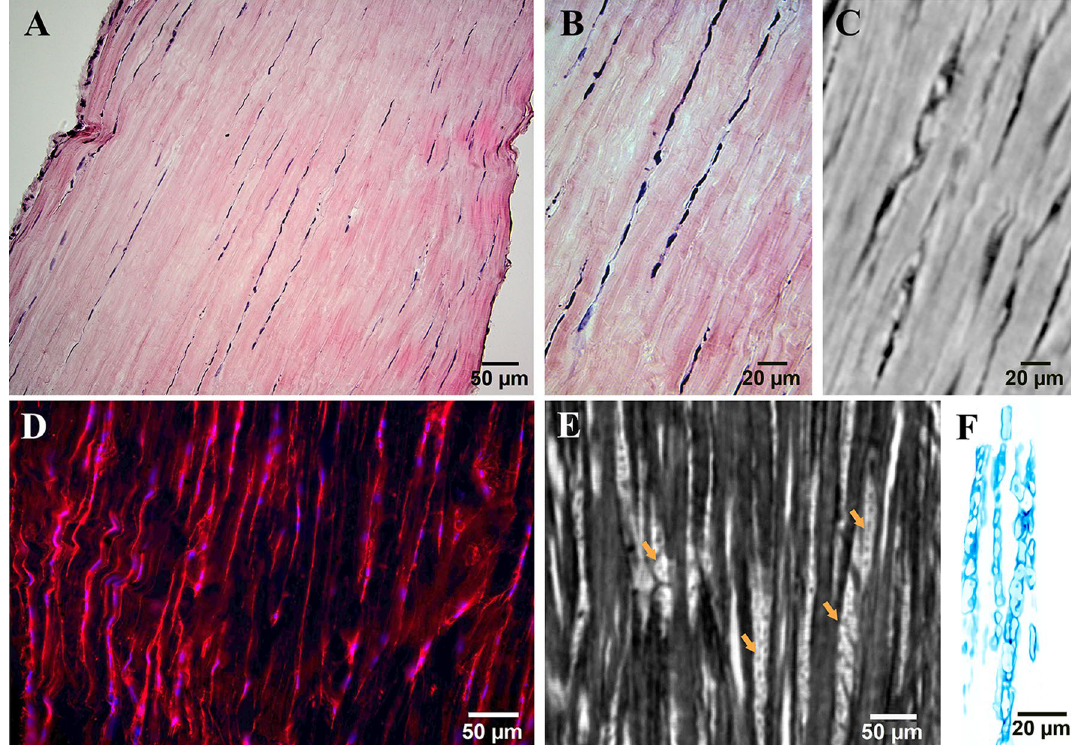
Figure 3. Comparison between fibers and cells observed by histology and by phase contrast enhanced tomography of fresh frozen samples in PBS. ( A ) Light microscope image (×20) of a histological slice stained with hematoxylin and eosin ; ( B ) ×40 magnification of ( A ); ( C ) phase contrast enhanced tomographic slice showing fibers; ( D ) Fluorescent image (×25) of an immunohistochemistry slice stained for collagen I (red) and DAPI (blue); ( E ) cells (orange arrows) between the collagen fibers in a fresh sample imaged by phase contrast enhanced tomography. In ( E ), the contrast was inverted to increase the cell visibility (white) over fibers (black). ( F ) Volume rendering showing a few inter-fiber cells acquired by phase contrast enhanced